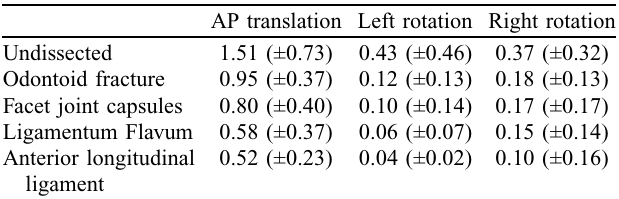
Table 1. Young’s Moduli (MPa) calculated from mechanical testing of the eight C1-C2 complexes at each successive dissection (mean and standard deviation).